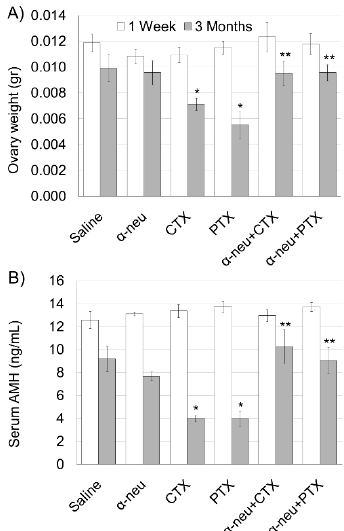
Figure 1. Anti-human epidermal growth factor receptor 2 (HER2/neu) protection from chemotherapy- induced ovarian toxicity in mice. Mature female mice (3 months old; 5 in each group) were injected Intraperitoneal (IP) twice at one week intervals with saline (control), anti-HER2/neu ( α -neu; mouse antibody clone 7.140.1; 40 mg/kg), cyclophosphamide (CTX; 100 mg/kg), paclitaxel (PTX; 8 mg/kg), α - neu and CTX or α -neu and PTX and were sacrificed one week (white bars) or three months (grey bars) later. ( A ) Ovary weight and ( B ) serum anti-Müllerian hormone (AMH) were measured. Bars are mean ± SEM. (*)—significantly different from control value ( p < 0.05). (**)—significantly different from chemo only group (CTX or PTX without anti-neu; p < 0.05).